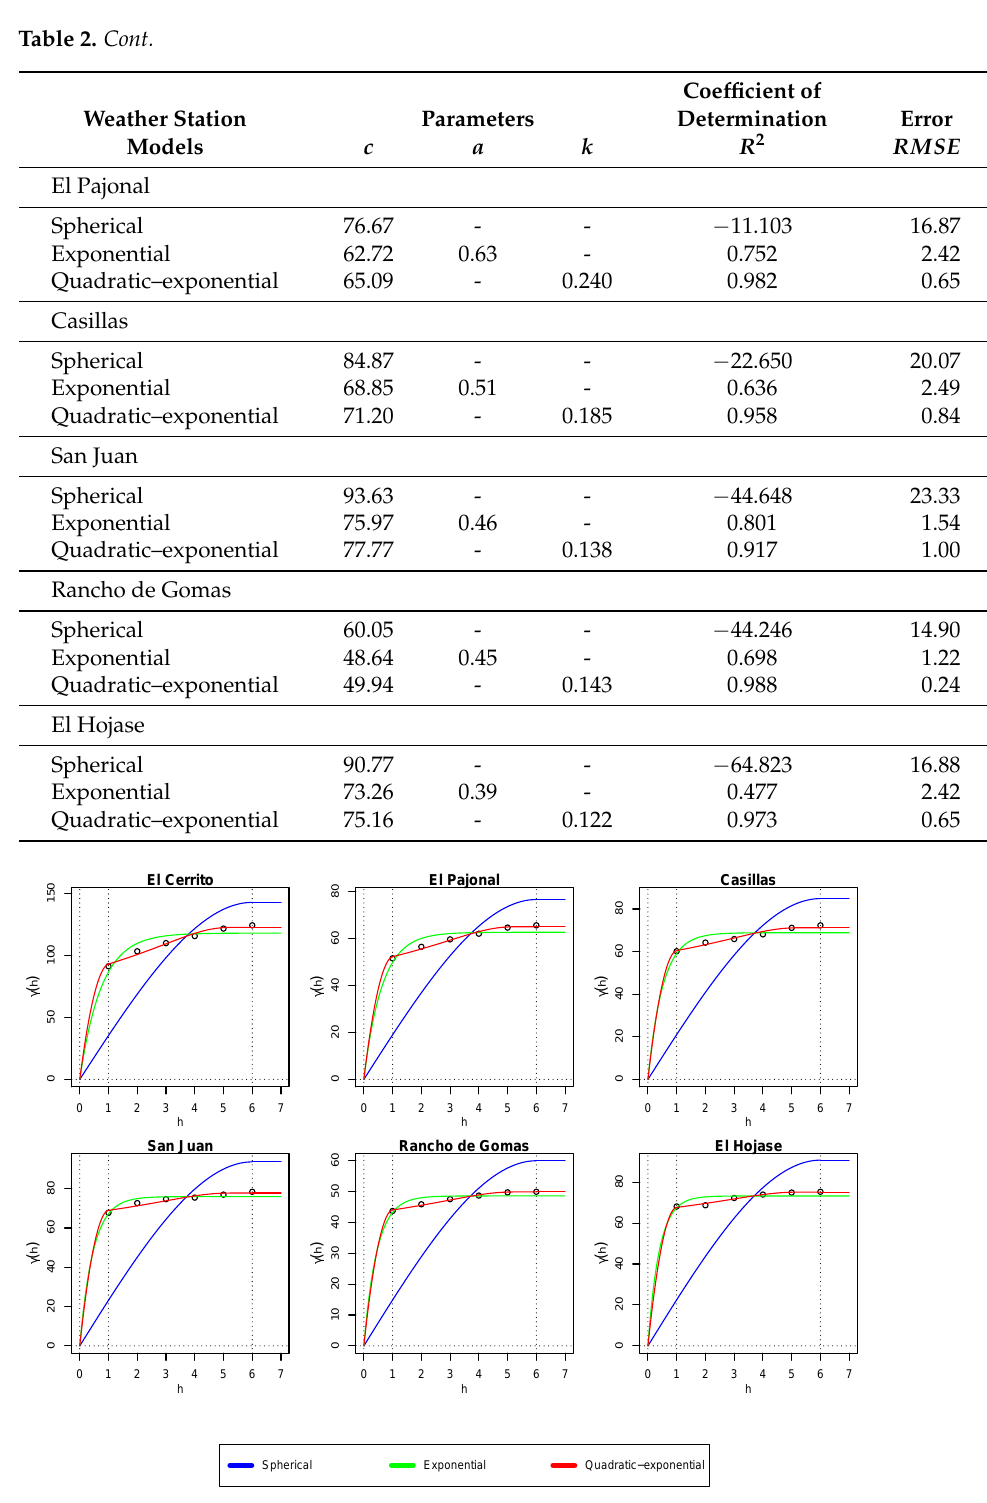
Figure 4. Curve fitting for each station’s variogram with the spherical (1), exponential (3) and quadratic–exponential (7) models. The initial time distance r 0 = 1 month and the maximal variability r = 6 months are tagged with dotted